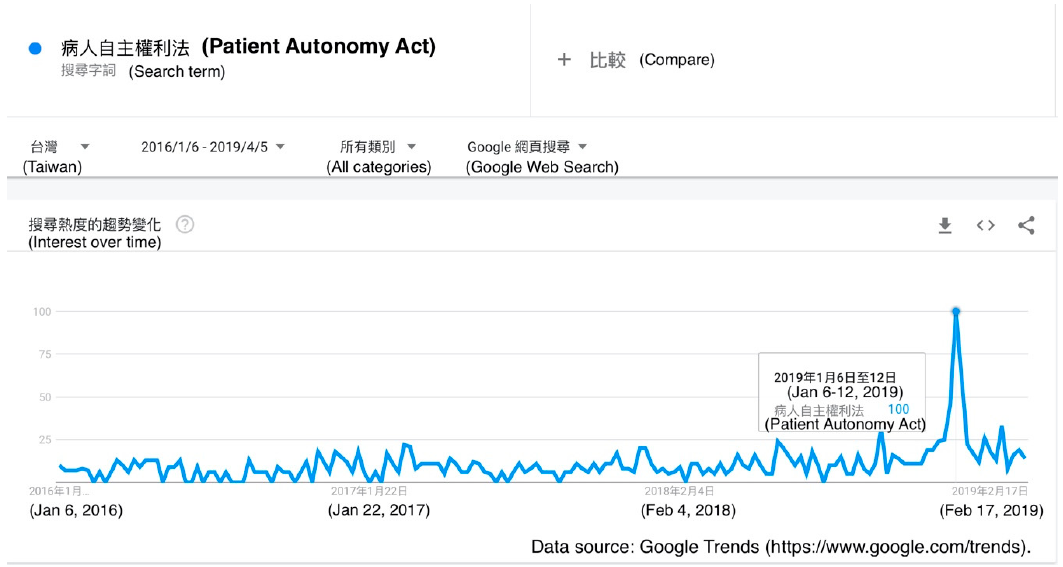
Figure 1. A Google Trends graph for the term “Patient Autonomy Act” (blue line) in Taiwan from 6 January 2016 to 5 April 2019.